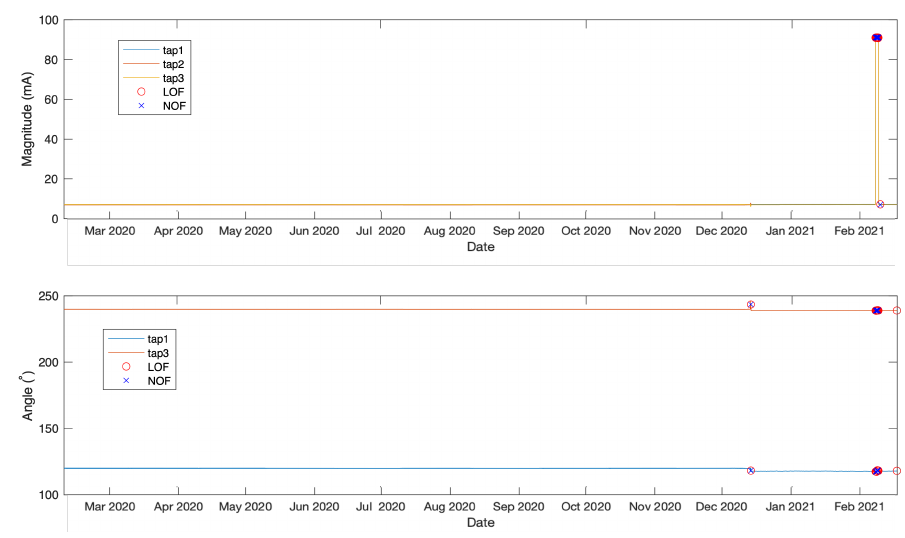
Figure 11. LOF and NOF outlier detection results.